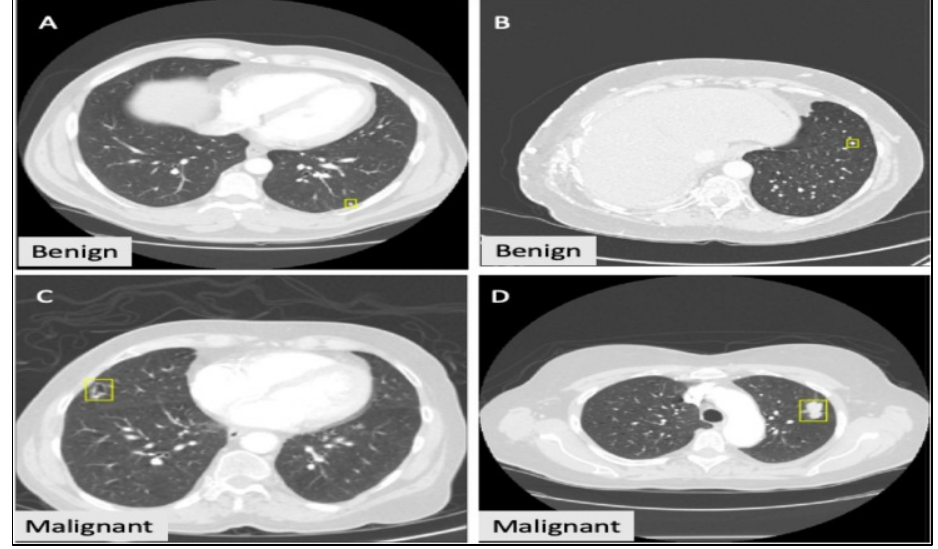
Figure 6. Lung classification results.